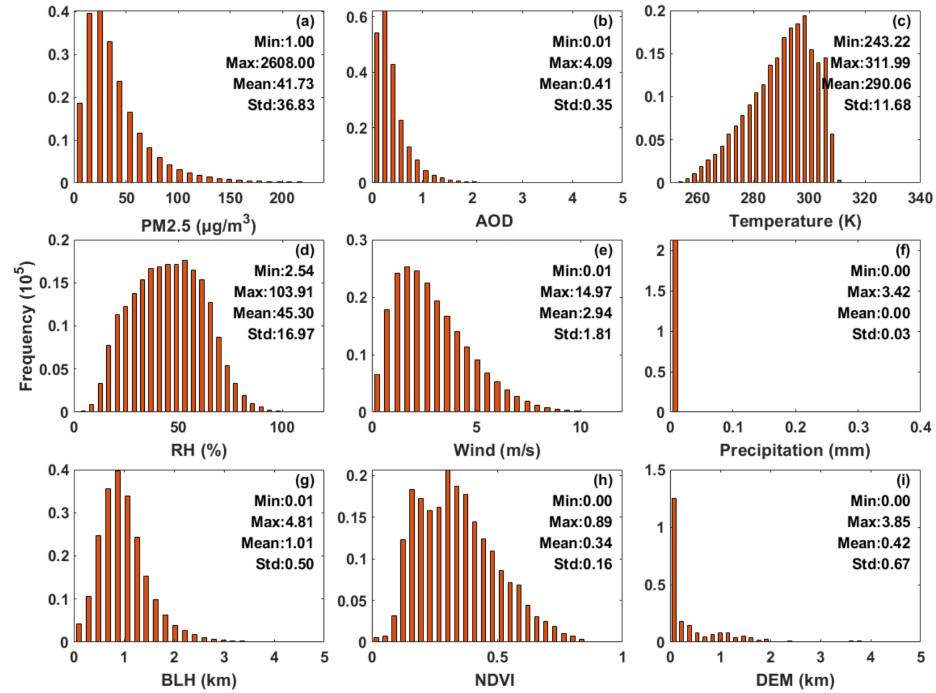
Figure 5. Statistical analysis of the datasets used in this study, including PM 2.5 , AOD, temperature, RH, wind, precipitation, BLH, NDVI, and